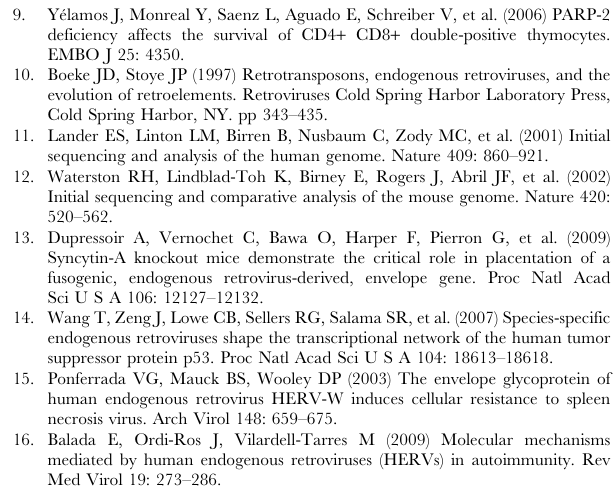
Figure S7 The promoter/enhancer activity of wild-type and p53 binding site deleted LTRs of GLN. ( A ) LTR sequence of GLN. The sequence of the putative p53 binding site is